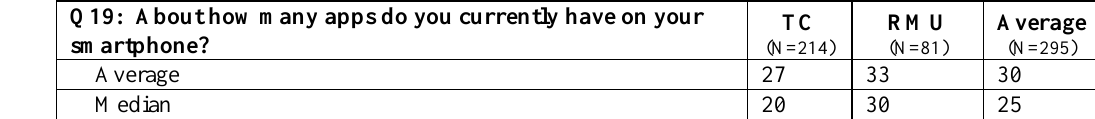
Table 2. RQ2: Number of apps installed on cellphone